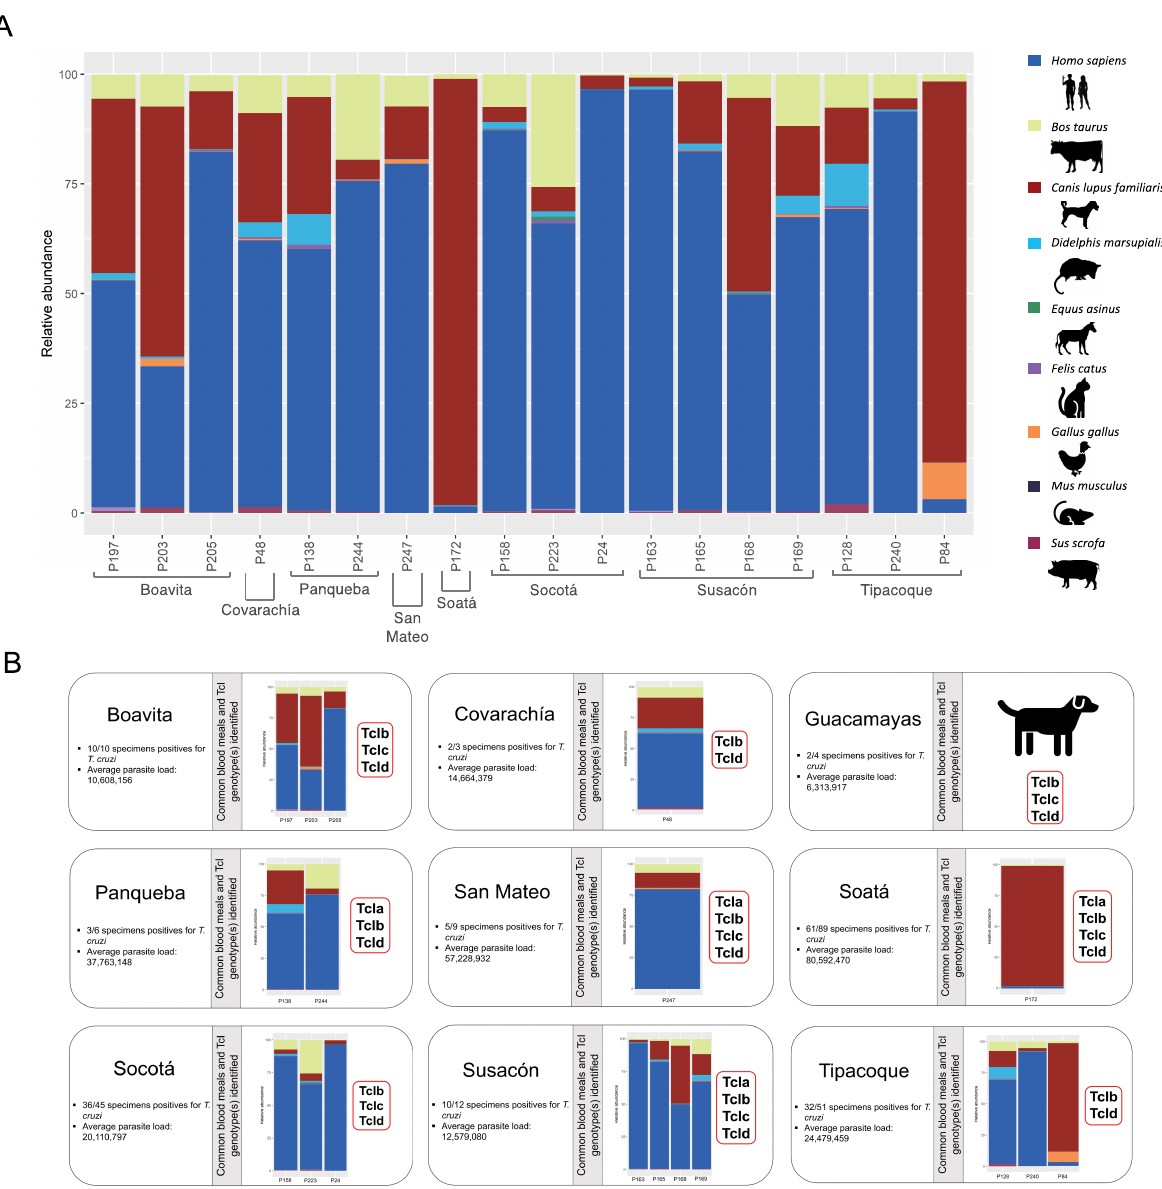
Fig 4. Summary of infection, parasite loads, feeding profiles, and TcI genotypes information of T . dimidiata specimens per municipality. A) The barplot shows the top 9 most common blood meals T . dimidiata fed on, the hosts cartoons were made by the authors. B) Each inset contains information per municipality, such as average parasite load (total samples collected per municipality), infection data, common blood meals, and TcI genotype identified per sample. Guacamayas’ sample was sequenced by Sanger; therefore, it does not appear in the barplot, but blood meal information is represented in the inset. Complete information of sequenced samples available in S4